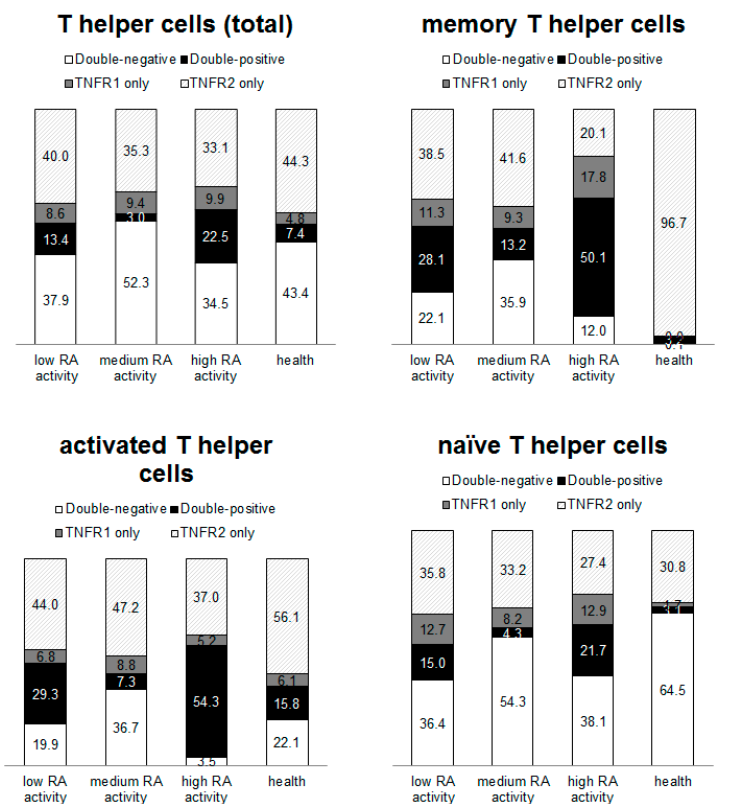
Figure 2. Subpopulations of T helper cells. Proportion of cells expressing type 1 and 2 receptors for TNF α among T helper cells. Data have been normalized to the total median value.